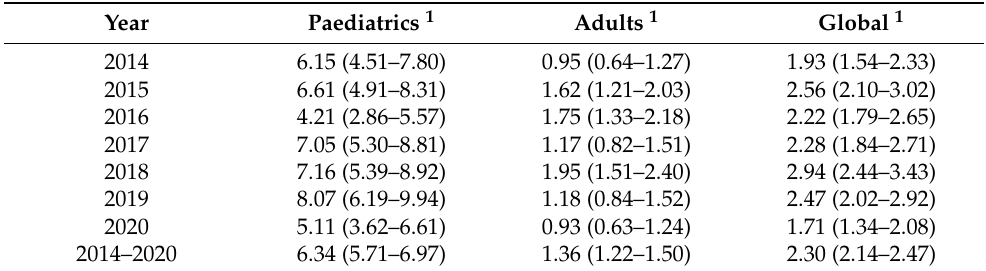
Table 1. The incidence of MD in Spain per year (from 2014 to 2020), calculated in paediatric patients, adults, and total number of